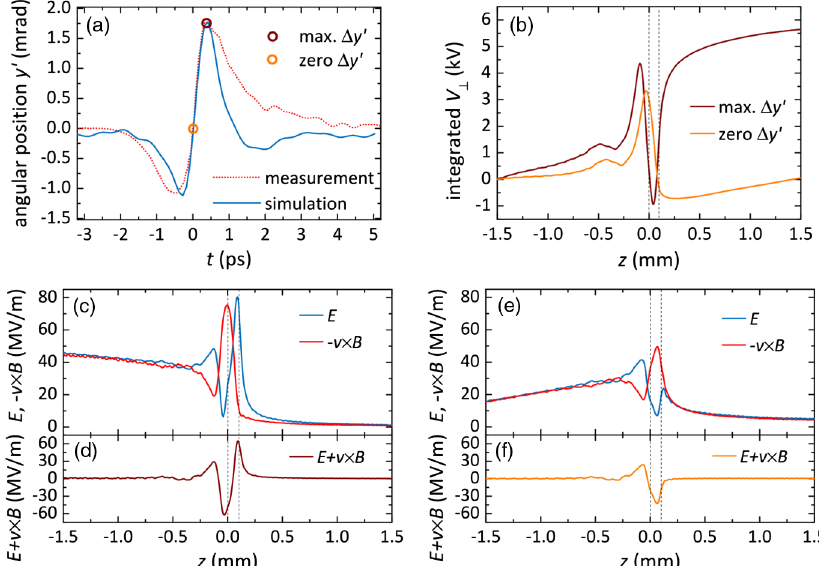
FIG. 4. Simulation results of angular position, integrated transverse voltage, and Lorentz forces experienced by the relativistic electrons. (a) Comparison between the measured and simulated final angular position of the electrons at different time delays. (b) – (f) compare the kinetics of two particles highlighted in (a): “ max. Δ y 0 ” with the maximum change in angular position and “ zero Δ y 0 ” with the angular motion integrated to zero. The two dashed vertical lines indicate the slit. (b) compares the integrated transverse voltage experienced by the two particles. (c) – (d) show the components and combined Lorentz force experienced by the “ max. Δ y 0 ” particle. (e) – (f) show the components and combined Lorentz force experienced by the “ zero Δ y 0 ”